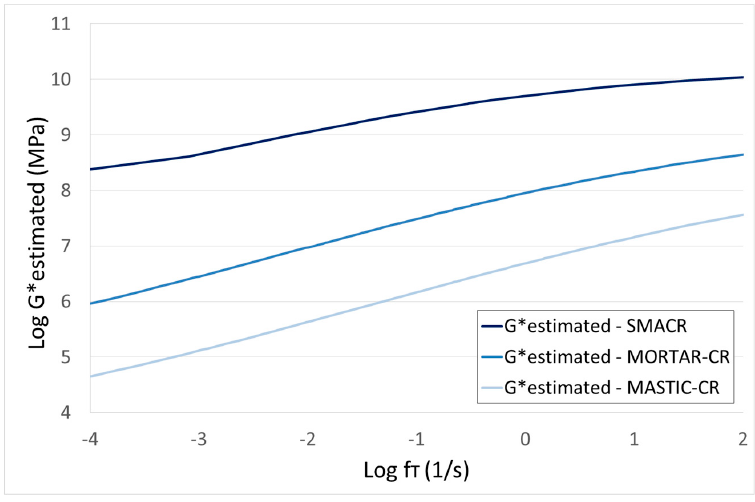
Figure 10. Sigmoidal model master curves.